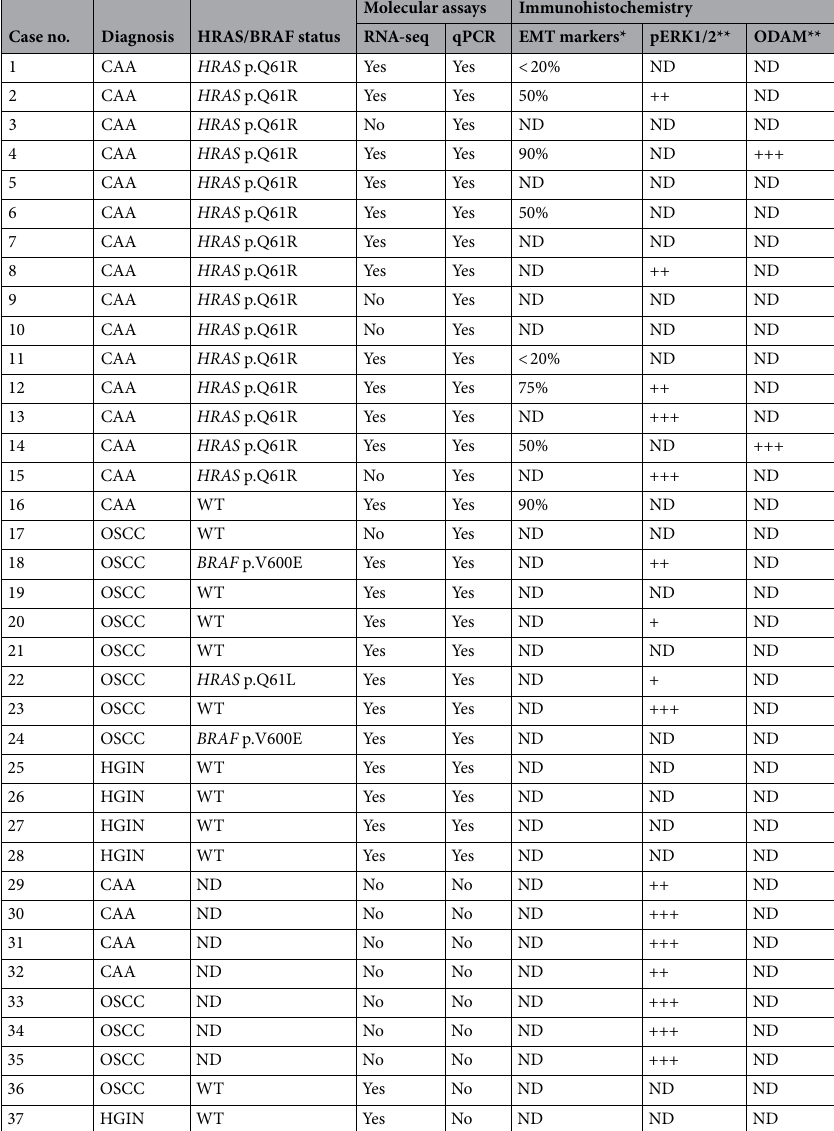
Table 1. Case description and assays performed. *Results are shown as a percentage of the area of each tumor exhibiting a staining pattern consistent with EMT, as described in the text. **Symbols denote the intensity of the signal observed as follows: weak (+), intermediate (++), or strong (+++). Scores of IHC results were not compared due to limited number of cases available for staining. Abbreviations: CAA canine